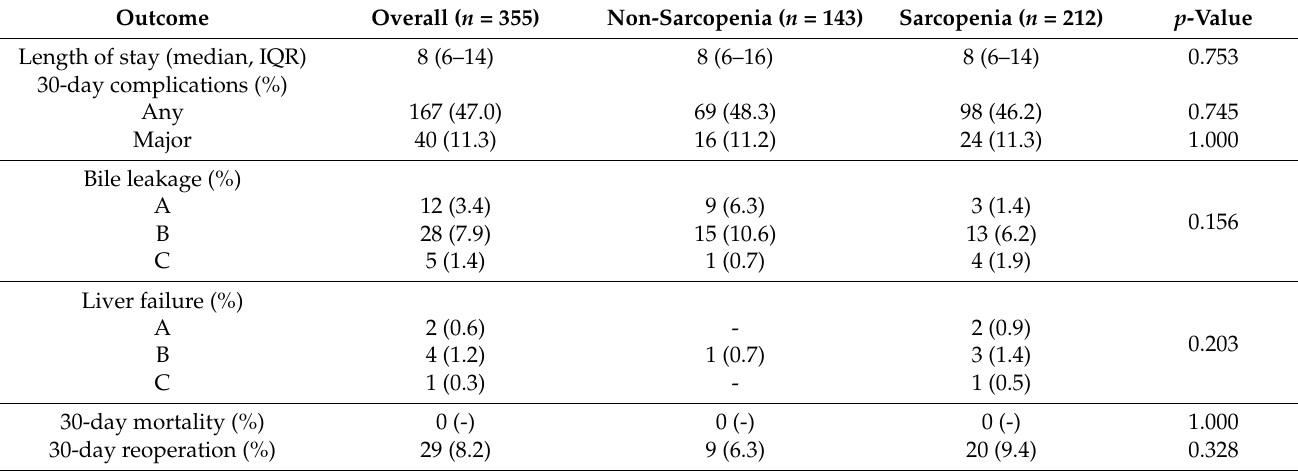
Table 2. Clinical outcomes of patients that underwent